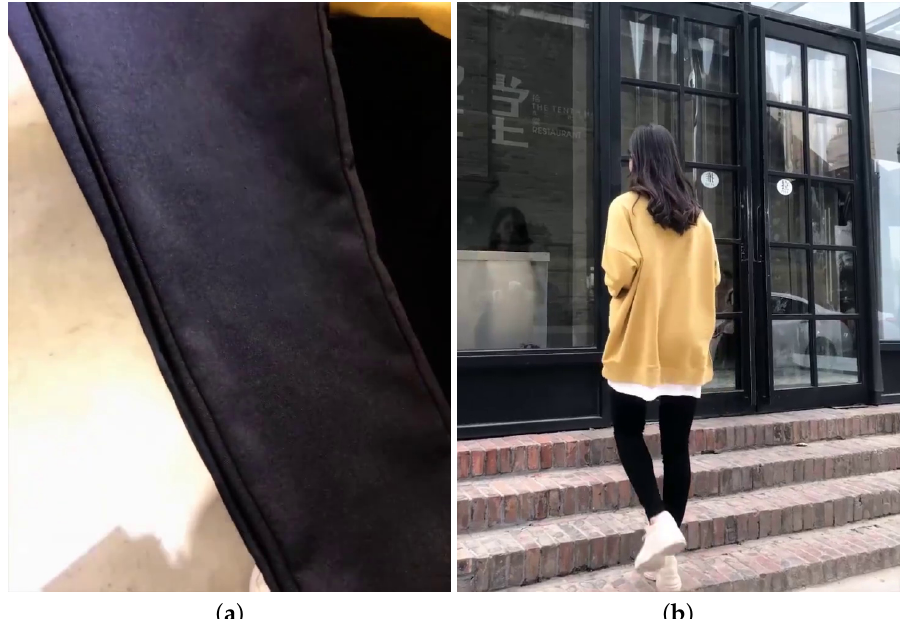
Figure 2. ( a ) Local feature, ( b ) Global feature. Local features reflect commodity details including texture, material, workmanship, etc. and global features reflect the overall effect of the commodity on the